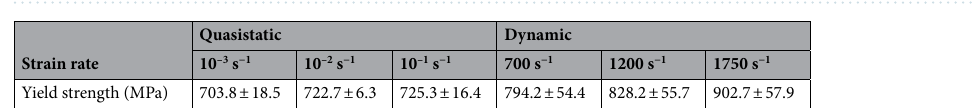
Figure 3. Mechanical behavior at quasistatic and dynamic strain rates: ( a ) quasistatic tensile engineering stress– strain curve; ( b ) quasistatic and dynamic strain rate compressive engineering stress–strain curves; ( c ) flow stress versus strain rate to determine strain rate sensitivity of the alloy at two different strain rate regimes.